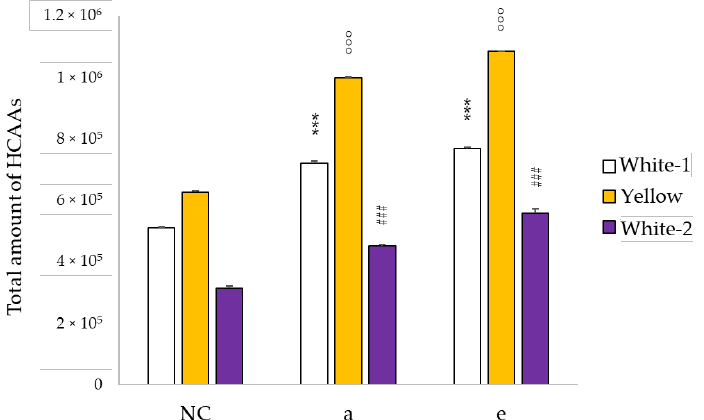
Figure 4. Chromatographic analysis of the fermented extracts for the three analyzed corn by-products. The sum of the chromatographic peak areas of [M+H] + ions of DCS, DFP, and CFP is reported. The means of 3 experiments were compared with the specific control values (3 replicates for each experiment). Statistic symbol legend: *, °, and # are reported for white-1 , yellow, and white-2 corn by-products, respectively. (*** , °°° , ### p < 0.001).